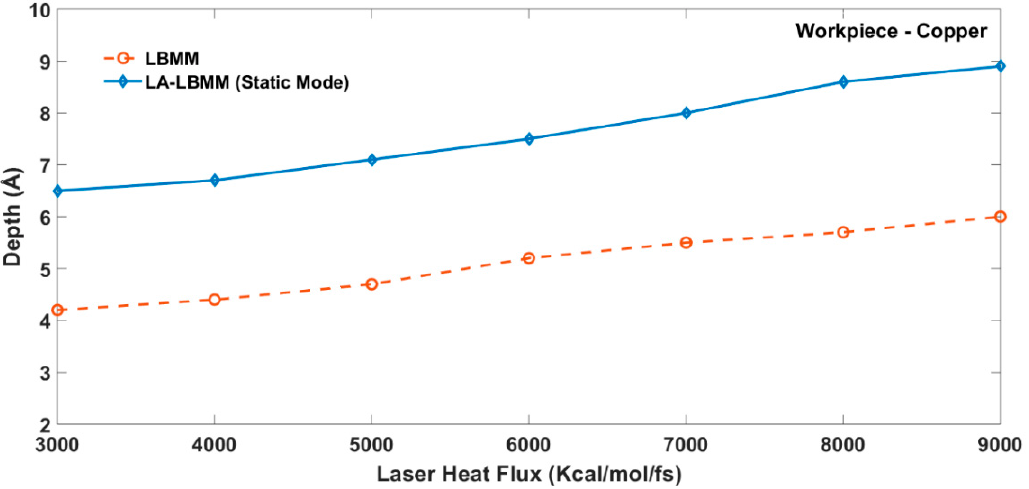
Figure 7. Variation in Cavity Depth with respect to Heat Flux during the LBMM Process and LA-LBMM Process (Static Mode) on Cu Substrate.